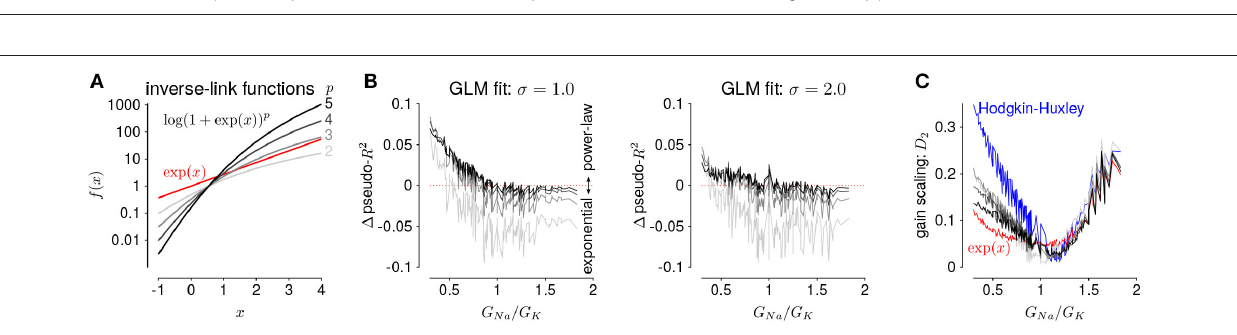
FIGURE 6 | Principal component analysis of the GLM stimulus and spike history filters trained across all values of G Na and G K . The GLMs were trained on all σ values with a spike history length of 150 ms. (A) The first two PCs (blue and red) of the stimulus filter. The normalized mean filter is given in black. (B) The projections of the stimulus filters onto the first two PCs. The shade of the points corresponds to G Na / G K where lighter indicates a higher ratio. The black points in (B,C,E,F) indicates GLM fit to the HH model with the best gain scaling (i.e., lowest D 2 ). (C) The stimulus filter PC weights (same as in B ) as a function of the G Na / G K ratio. (D) The stimulus filter PC weights as a function of the gain scaling factor ( D 2 ) observed in the HH simulation fit by the GLM. (E–H) Same as (A–D) for the GLMs’ spike history filters. The first 20 ms of the spike history filters were excluded from analysis to avoid effects from the strong refractory period.